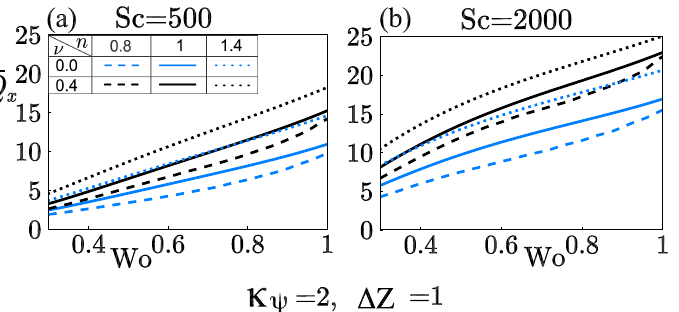
Figure 10. Rate of mass transport ¯ Q x as a function of Wo at different flow behavior indices n and the steric factor ν . ( a ) Sc = 500 and ( b ) Sc =